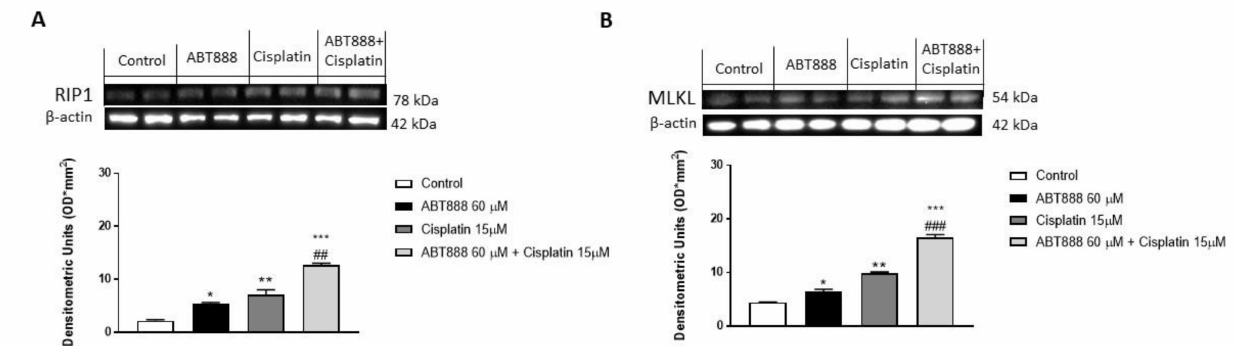
Figure 9. Effect of ABT888 and cisplatin on necrosis pathway in CAL27 cell culture. The association of ABT88 and cisplatin increased the expression of necrosis marker RIP1 and MLKL compared to the single treatments on CAL27 cells ( A , B ). Data are representative of at least three independent experiments. ( A ) * p < 0.05 vs. the control; ** p < 0.01 vs. the control; *** p < 0.001 vs. the control; ## p < 0.01 vs. cisplatin group. ( B ) * p < 0.05 vs. the control; ** p < 0.01 vs. the control; *** p < 0.001 vs. the control; ### p < 0.001 vs. cisplatin